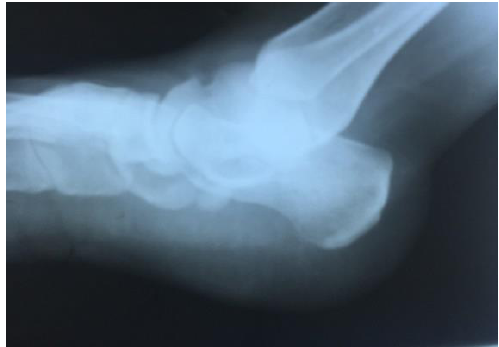
Figure 2 : Pre-oparative X